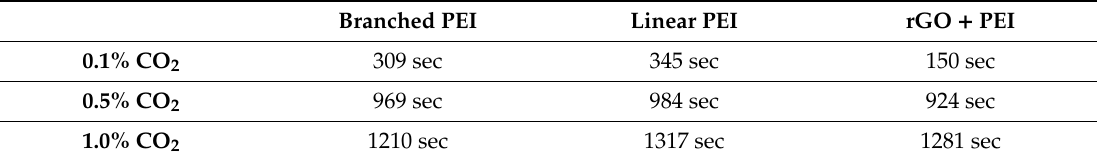
Figure 15. ( a ) Adsorption time for each coating at different CO 2 concentrations, ( b ) recovery time for each coating at different CO 2 level. The recovery time for the linear PEI with rGO reflects only the time to stabilize the desorption to the captured CO 2 value.